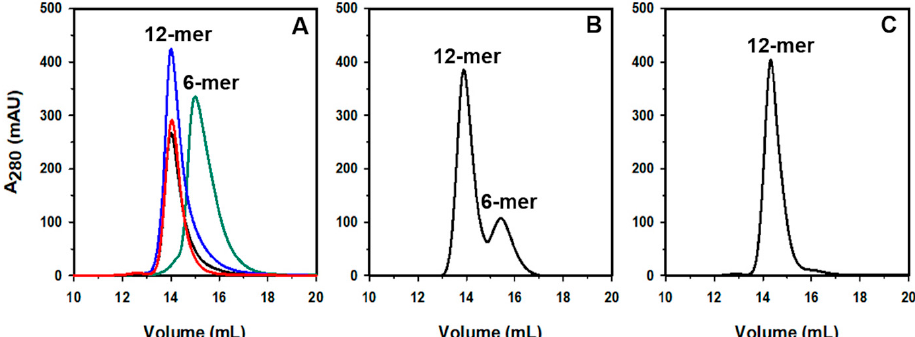
Figure 1. The multimeric assembly of Pa Dps is affected by divalent metal ions or pH. Pa Dps samples were equilibrated in distinct buffer conditions and then chromatographed on a calibrated Superdex S200 column equilibrated and eluted with the same buffer: ( A ) 75 mM Tris pH 7.5 (green); 75 mM Tris pH 7.5 and 1 mM Mg 2+ (blue), 75 mM Tris pH 7.5 and 0.5 mM Ca 2+ (black), 75 mM Tris pH 7.5 and 0.5 mM Mn 2+ (red); ( B ) 75 mM Bis-Tris pH 6.5. ( C ) 75 mM Bis-Tris pH 6.0.